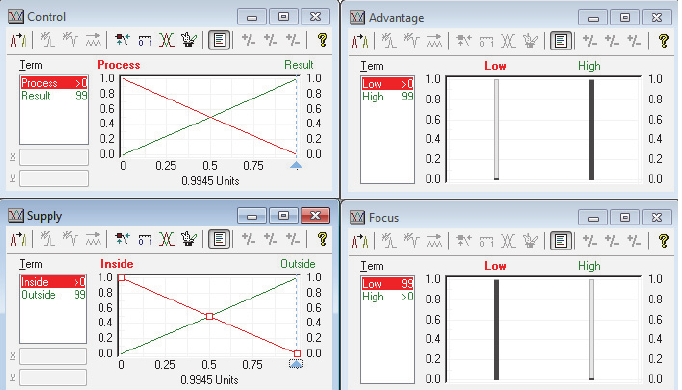
Fig. 9. Studying the results of strategies alignment in controlling outcome and supply from outside Based on Fig. 9, it is clear that if the control at the right of the model is towards the result and supply is also towards the outside of the organization, the alignment of business strategies goes toward the ad- vantage of higher distinction (higher cost) and the area with a more separation (lower focus). In this way, the main modes of the model were displayed in 5 sections. According to the calculated rules, the experts' questionnaire data was entered into the software and based on the results, it was clear how the alignment of strategies was explained in terms of academic experts. The results are presented in Table 12. The result of strategy alignment based on the output of the software HR strategies Controlling Outcome - Supply- Controlling Process - Supply- Controlling Result - Supplying ing from inside (committed) ing from inside (parental) from outside